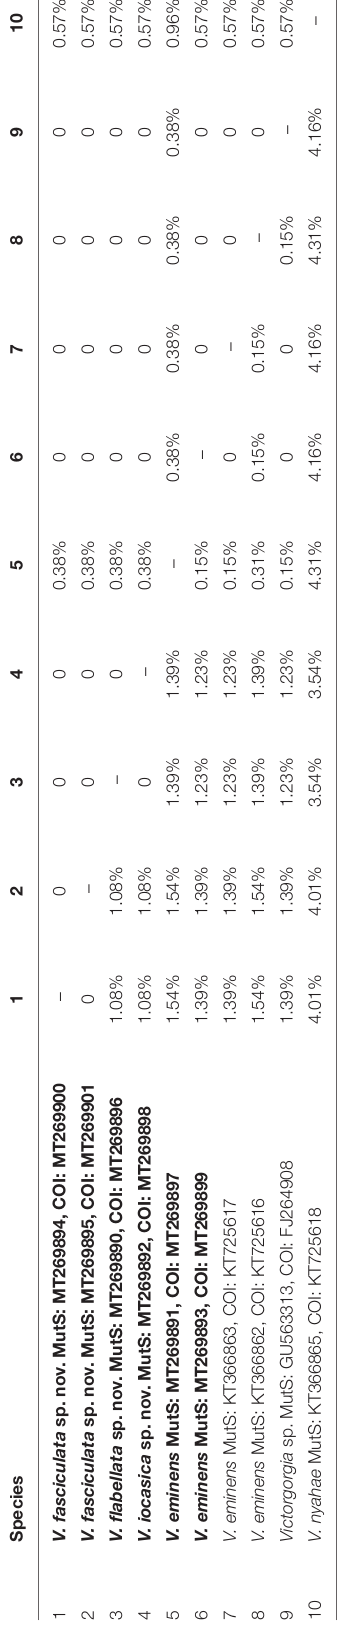
Polyps Polyps scattered around branches and at right angles. Calyces distinct, usually clumped both at branch tips and along branches, resulting in their uneven distribution with notable polyp-free regions ( Figures 3D,E ). Polyps contracted, and most fully retracted into calyces in preservation, resulting in rounded polyp heads with tentacles folded over the mouths ( Figures 3A– E,H,I ). In preservation, polyp heads approximately 2.5–4.3 mm wide, and up to 4.5 mm long in partly expanded ones; calyces of tentacles with a row of about 7–9 pinnules, with the middle pinnules the